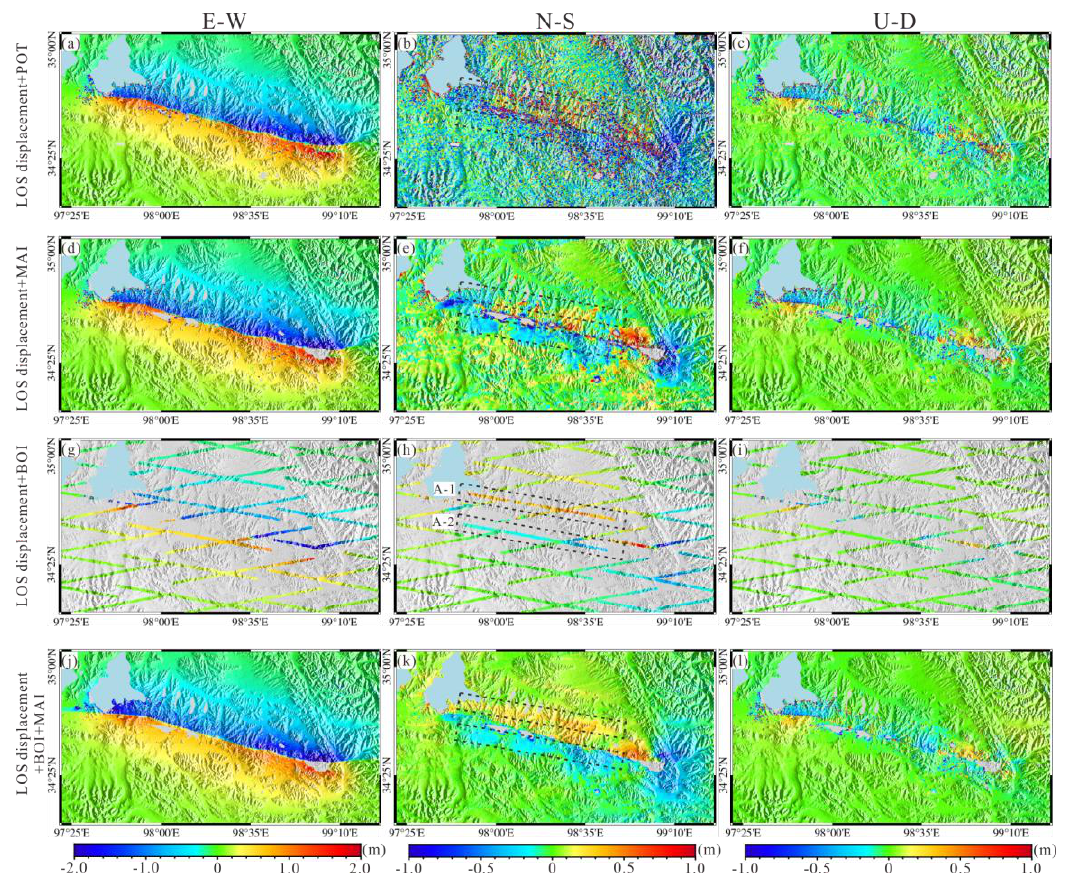
Figure 6. The 3D coseismic displacement maps of the 2021 Maduo earthquake. ( a – c ) are obtained by integrating complete LOS displacements and POT measurements. ( d – f ) are obtained by integrating complete LOS displacements and MAI measurements. ( g – i ) are obtained by integrating complete LOS displacements and BOI measurements. ( j – l ) are obtained by MAI-derived and interpolated BOI-derived 3D displacements. The color bars are set on the same scale for each displacement component for easier comparison. To enable the comparison of N – S component details, the two black rectangles located in northern and southern walls of the fault are marked “ A-1 ” and “ A-2 ” , respectively.